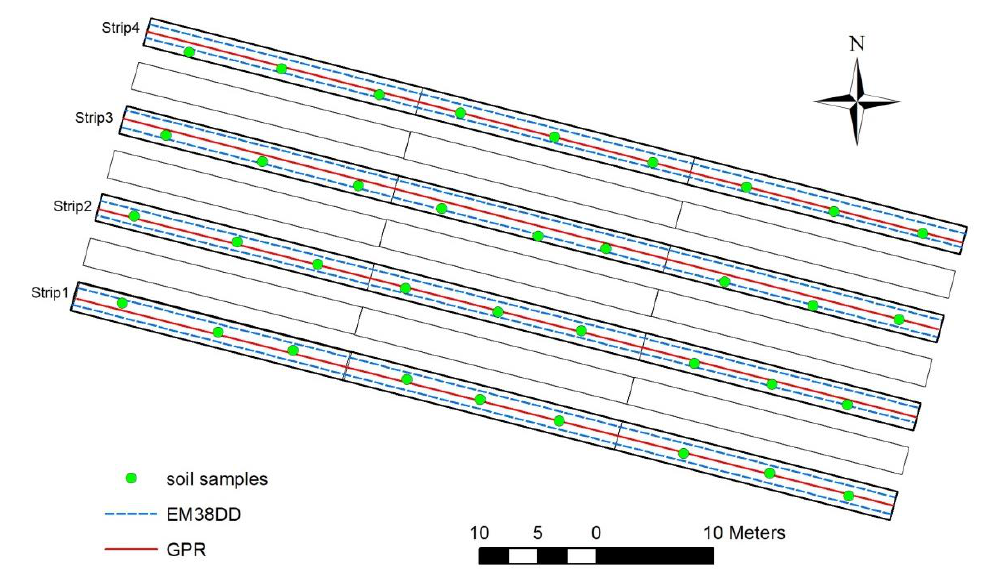
Figure 1. The field experiment with the soil water content (SWC) sampling locations (green dots) the electromagnetic induction (EMI) (blue dashed lines) and Ground Penetrating Radar (GPR) acquisitions along transects (red